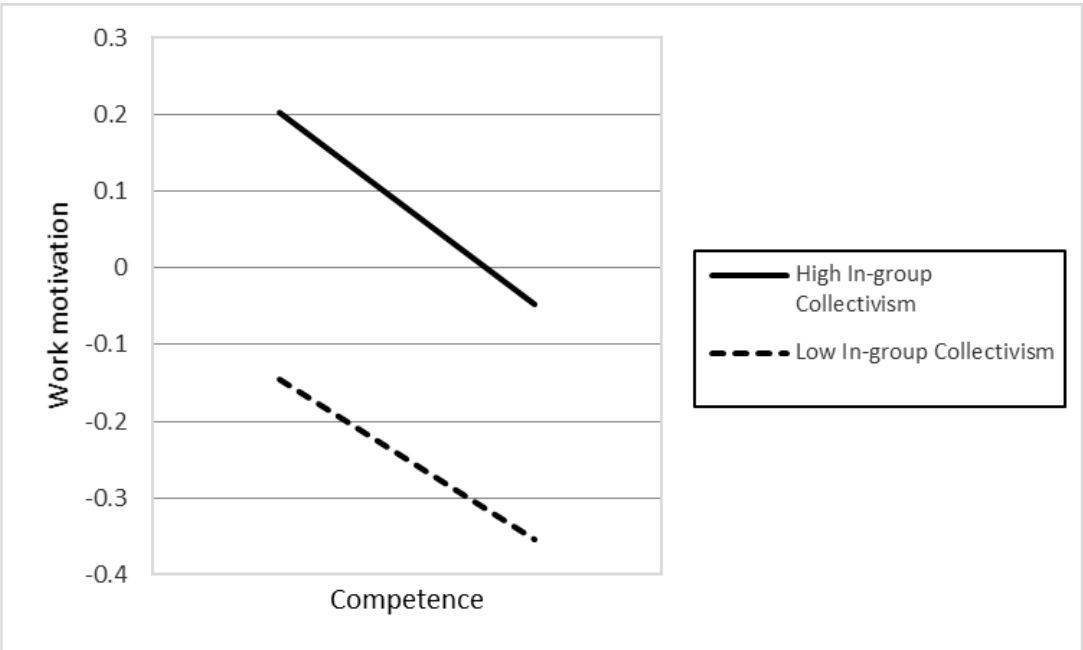
Figure 2. The association between competence and work motivation at different levels of in-group collectivism.